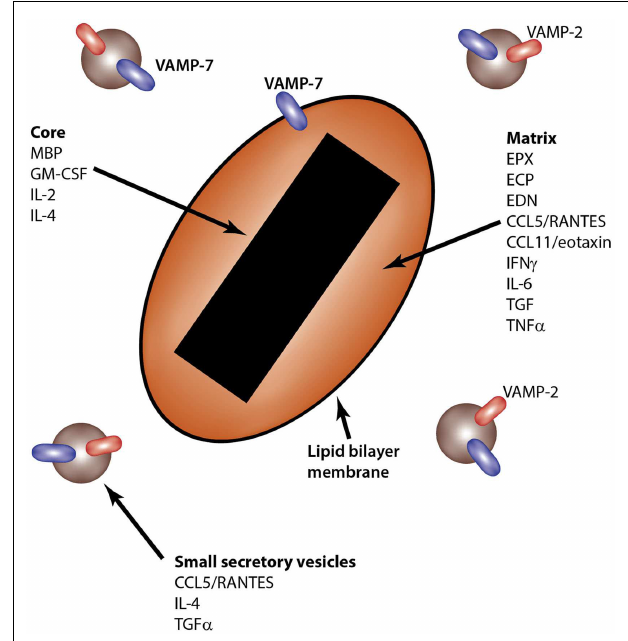
FIGURE 2 | Intragranular sites of storage for eosinophil-derived cytokines .The eosinophil crystalloid granule consists of two internal compartments: the core, enriched in MBP, and the matrix, which contains EPX, ECP, and EDN, among other granule components. Small secretory vesicles also transport cytokines, including CCL5/RANTES, IL-4, andTGF α . SNARE molecules are shown in the lipid bilayer membranes of granules and secretory